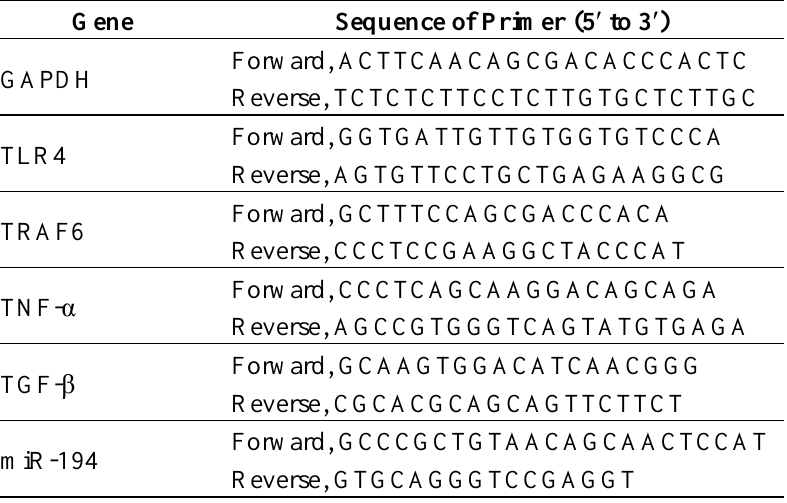
Table 1. Lists of primers for PCR